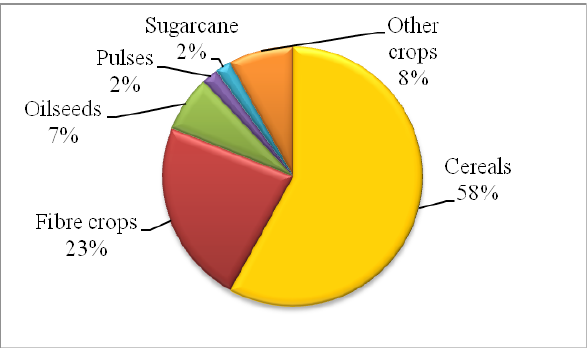
Fig. 2: The share of unutilized residues in total residues generated by different crops in India (Source: self-generated using data from